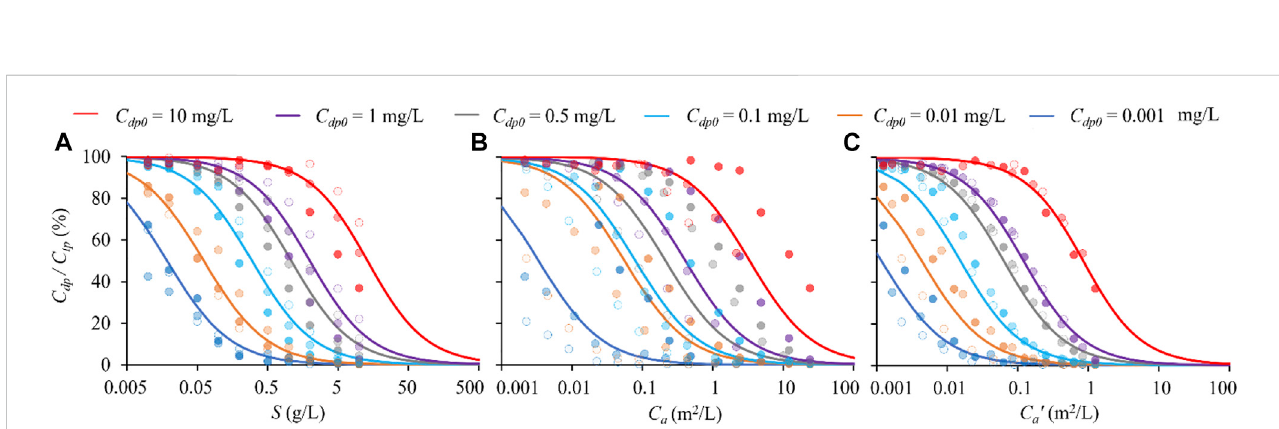
FIGURE 4 Relationship betweentheproportion ofdissolved Patadsorption equilibrium( C dp / C tp )and totalsedimentconcentration( S ) (A) ,totalarea concentration of sediment ( C a ) (B) and the total effective surface area concentration of sediment ( C a ′ ) (C) for graded sediment under different initial dissolved P concentration ( C dp0 ), based on the data from laboratory experiments (colored symbols) and equilibrium adsorption model (solid line). The color symbols in full, half and empty refer to the fi ne ( D 50 = 4.61 µm), median ( D 50 = 20.89 µm), and coarse ( D 50 = 51.56 µm) sediment used in the